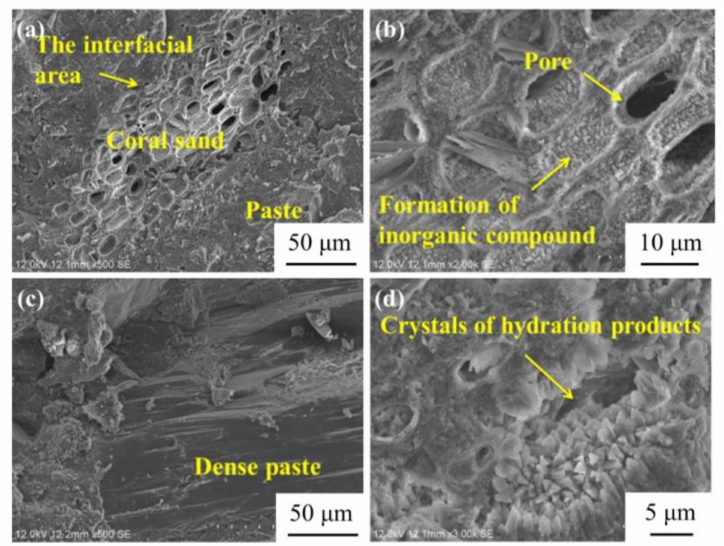
Figure 16. The microstructures of USMC: ( a ) Interface area, ( b , c ) Paste area, ( d ) hydration prod- ucts area.